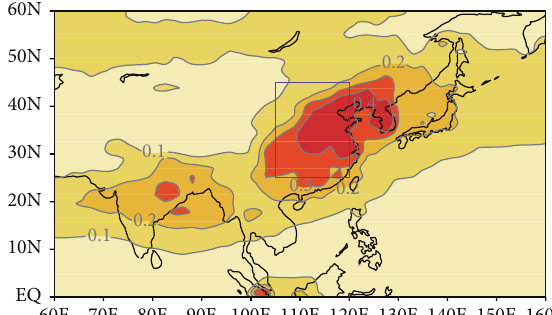
Figure 1: Spatial distribution of the 550 nm aerosol optical depth difference between two experiments for summer (JJA) derived from the CSIRO-Mk3.6.0 model. The purple box represents the study region (East China; 25 ∘ –45 ∘ N, 105 ∘ –120 ∘